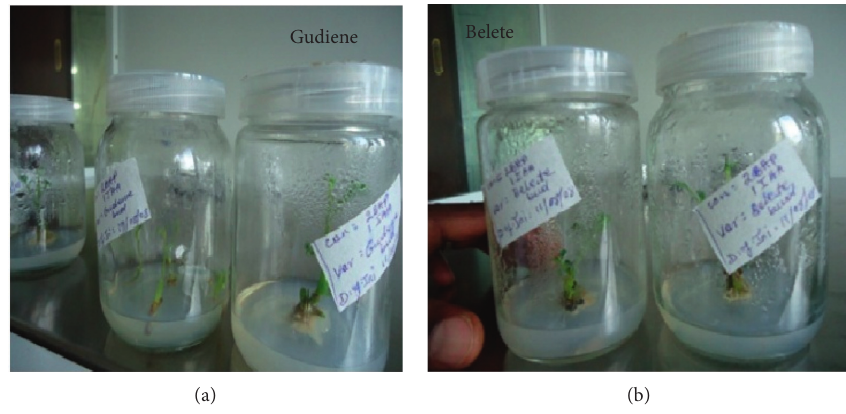
Figure 1: In vitro shoot initiation in Gudiene and Belete varieties of